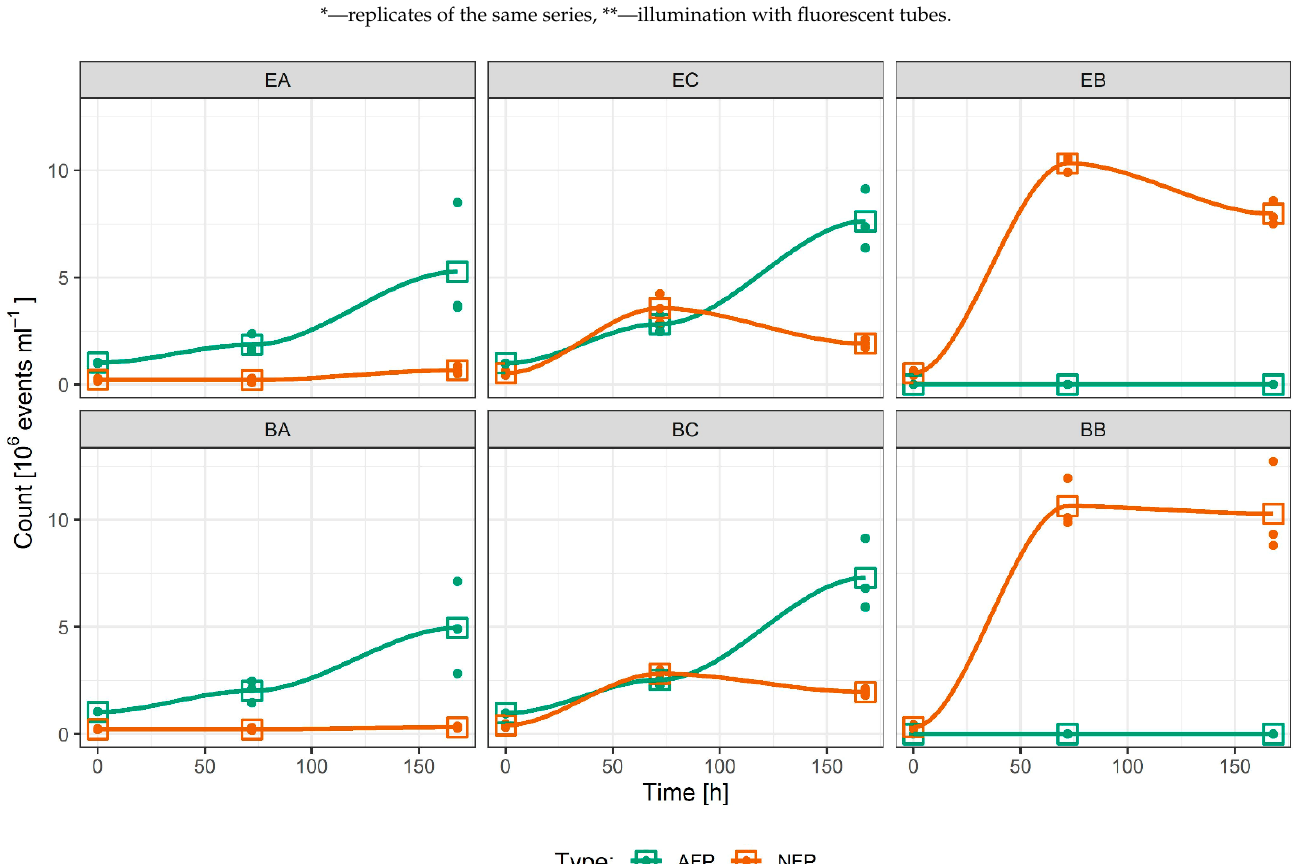
*—replicates of the same series, **—illumination with fluorescent tubes.